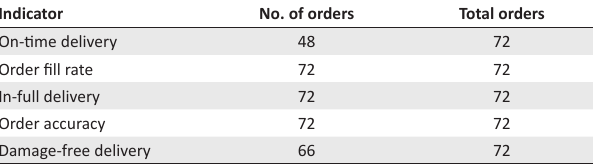
TABLE 4: Perfect order completion indicators. Indicator